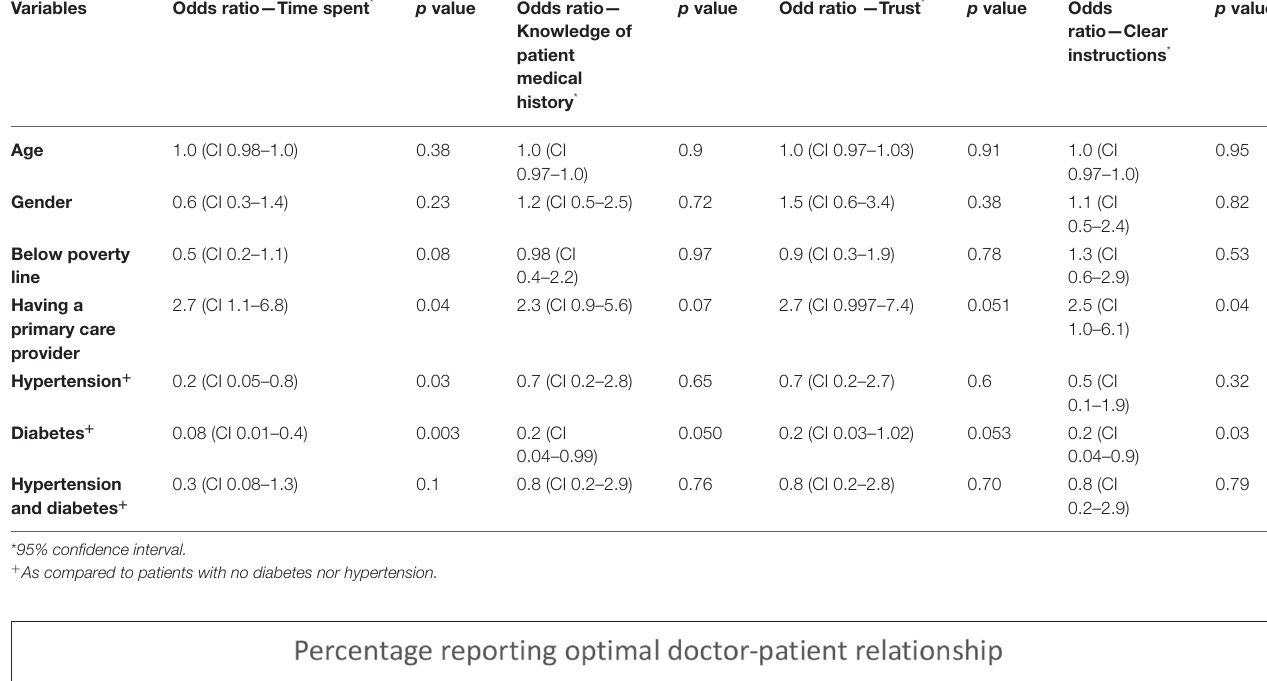
TABLE 4 | Logistic regressions for the perception of the patient-doctor relationship. Variables Odds ratio—Time spent * p value Odds ratio—